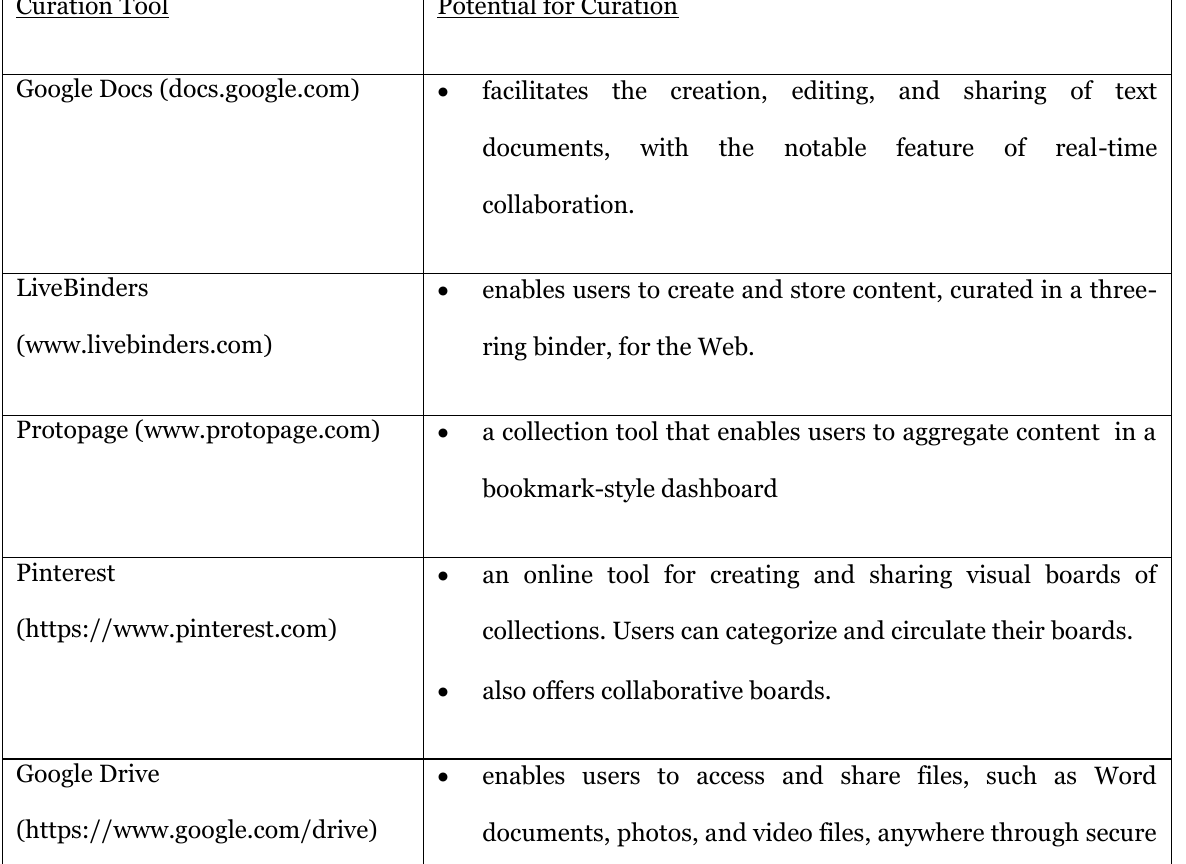
Ten Recommended Content Curation Tools (Sharma & Deschaine, 2016) Curation Tool Potential for Curation